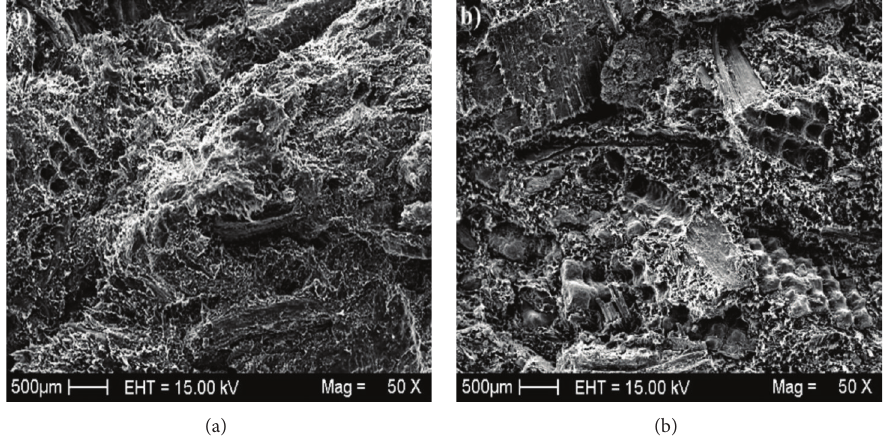
Figure 7: SEM micrographs of fracture surfaces of sample from composites at 50x: (a) 0.5% AOs and (b) 20% FRs